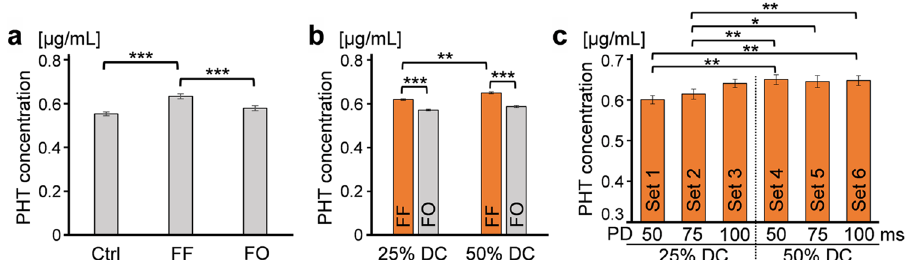
Figure 3. Unbound, free PHT concentrations in dialysates following equilibrium dialysis of PBS-BSA-PHT solution with different conditions. The PHT levels were compared ( a ) among the samples of unsonicated control (‘Ctrl’), at the FUS focus (‘FF’), and outside the focus (‘FO’), with one-way repeated measures ANOVA (*** p < 0.001), ( b ) between the samples with 25% and 50% DC conditions, with two-tailed paired t -test (** p < 0.01, *** p < 0.001), and ( c ) across the ‘FF’ samples with the varying sonication parameter sets 1–6 in Supplementary Table S1, with one-way repeated measures ANOVA (* p < 0.05, ** p < 0.01). Data shown as mean ± standard error.